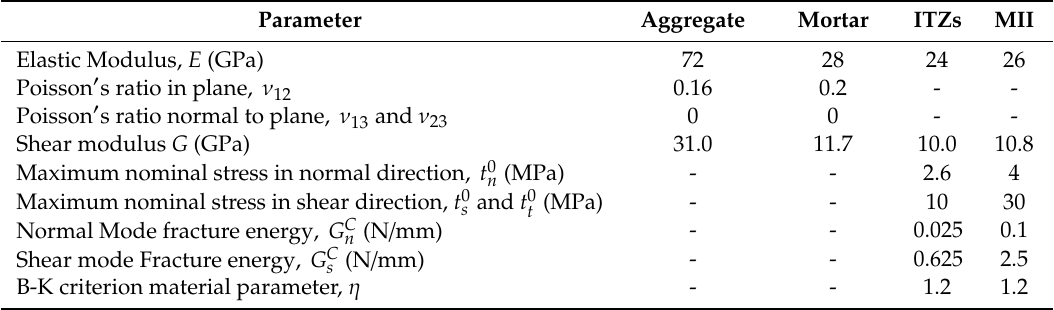
Table 3. Material properties of aggregate particles, mortar particles, interfacial transition zones (ITZs), and mortar internal interface (MII).